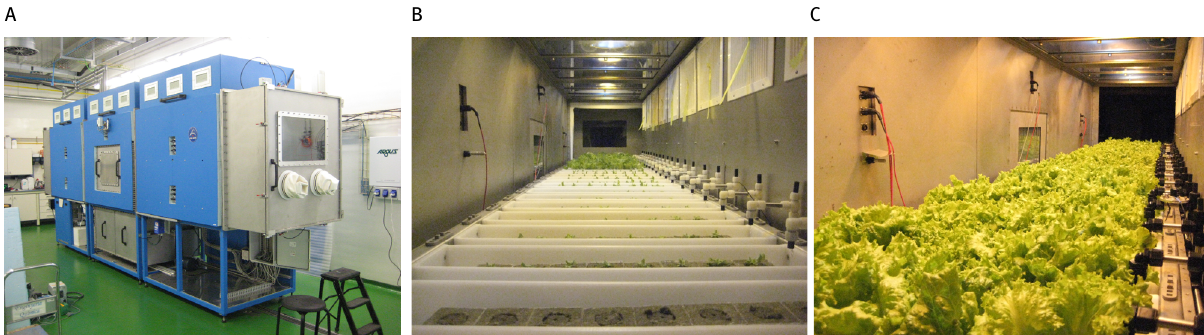
Figure 2: Higher Plant Compartment (HPC) of the European Space Agency’s MELiSSA program. The HPC was developed by the University of Guelph as an international partner in the MELiSSA program. A) Exterior of HPC at the Melissa Pilot Plant (MPP) showing glovebox airlocks (both ends) and basic mechanical systems; B) Example of a staggered, conveyor-style planting protocol for continuous lettuce production;